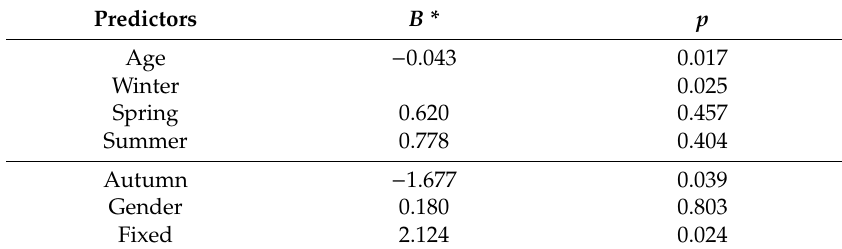
Table 2. Predictors in the logistic regression model predicting the probability of dying by suicide under the influence of